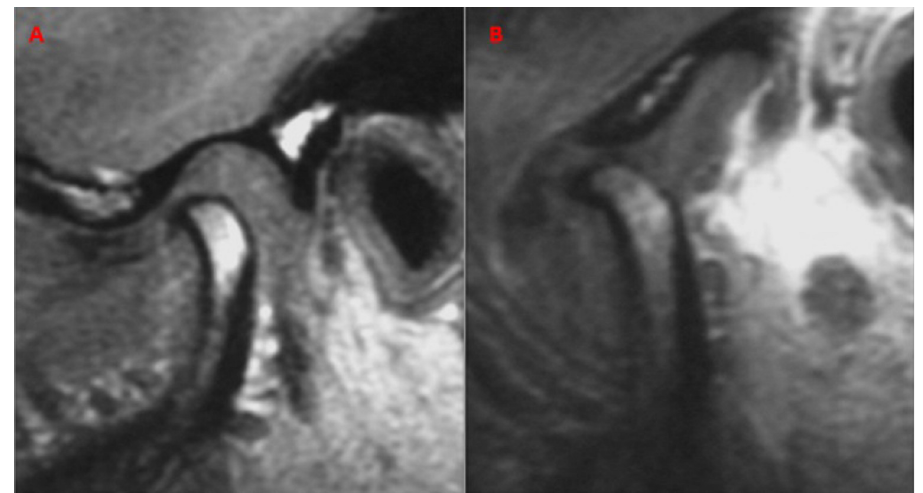
Fig 4. MAICD example. A: before the arthrocentesis. B: four months after arthrocentesis.